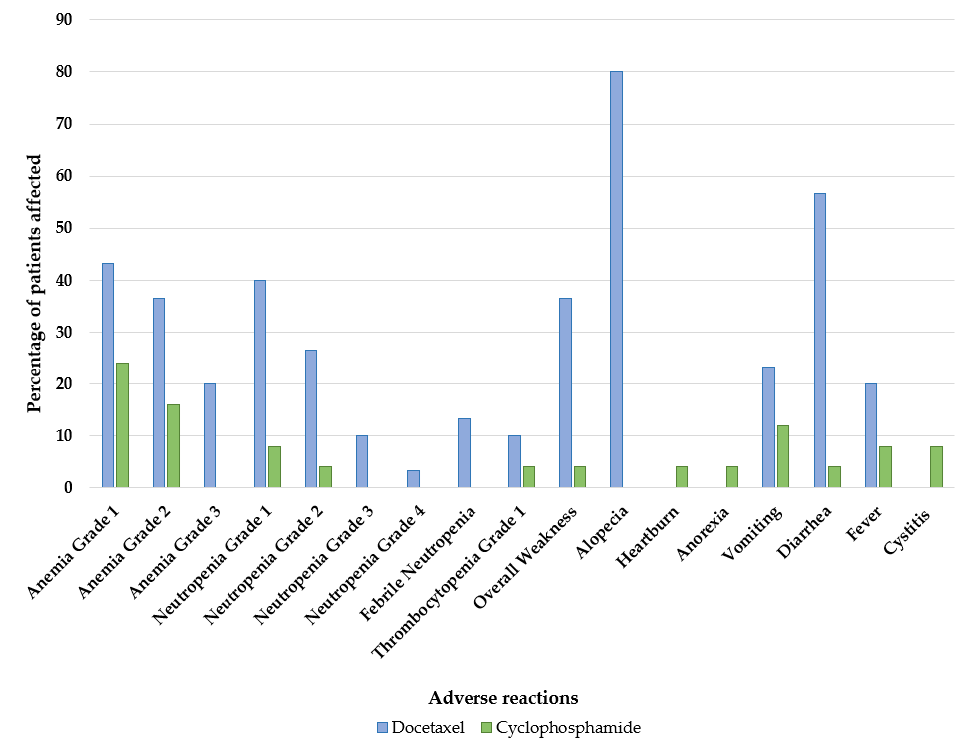
Figure 7. Depiction of the incidence of adverse events reported in patients undergoing conventional docetaxel versus metronomic cyclophosphamide therapy as reported by Vorob’ev et al., 2011 [46].